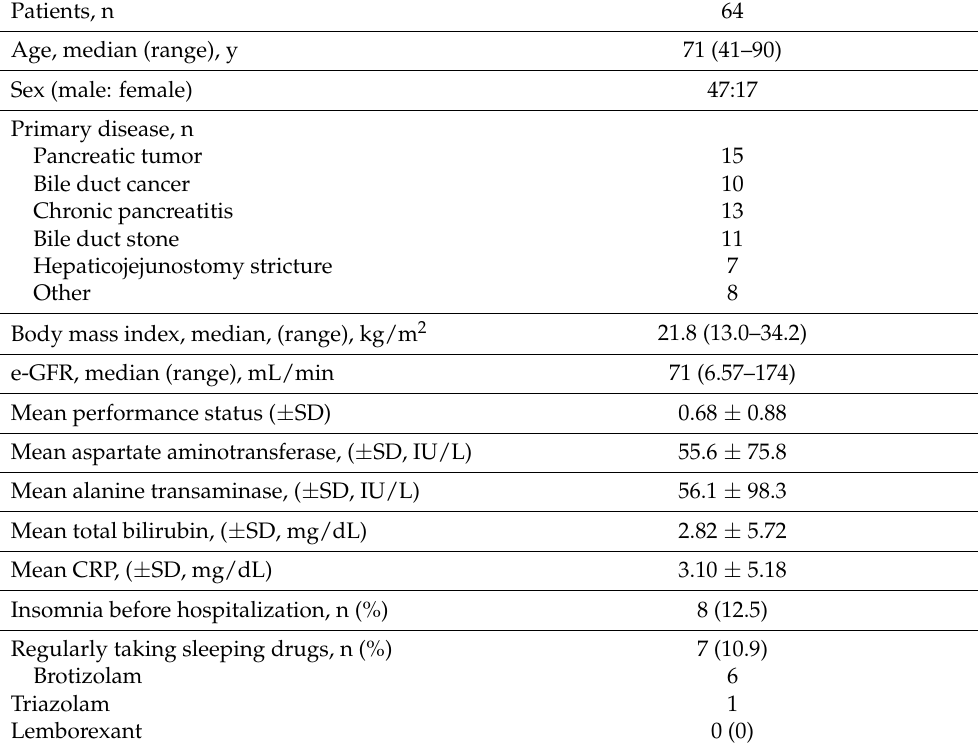
Table 1. Patient characteristics.